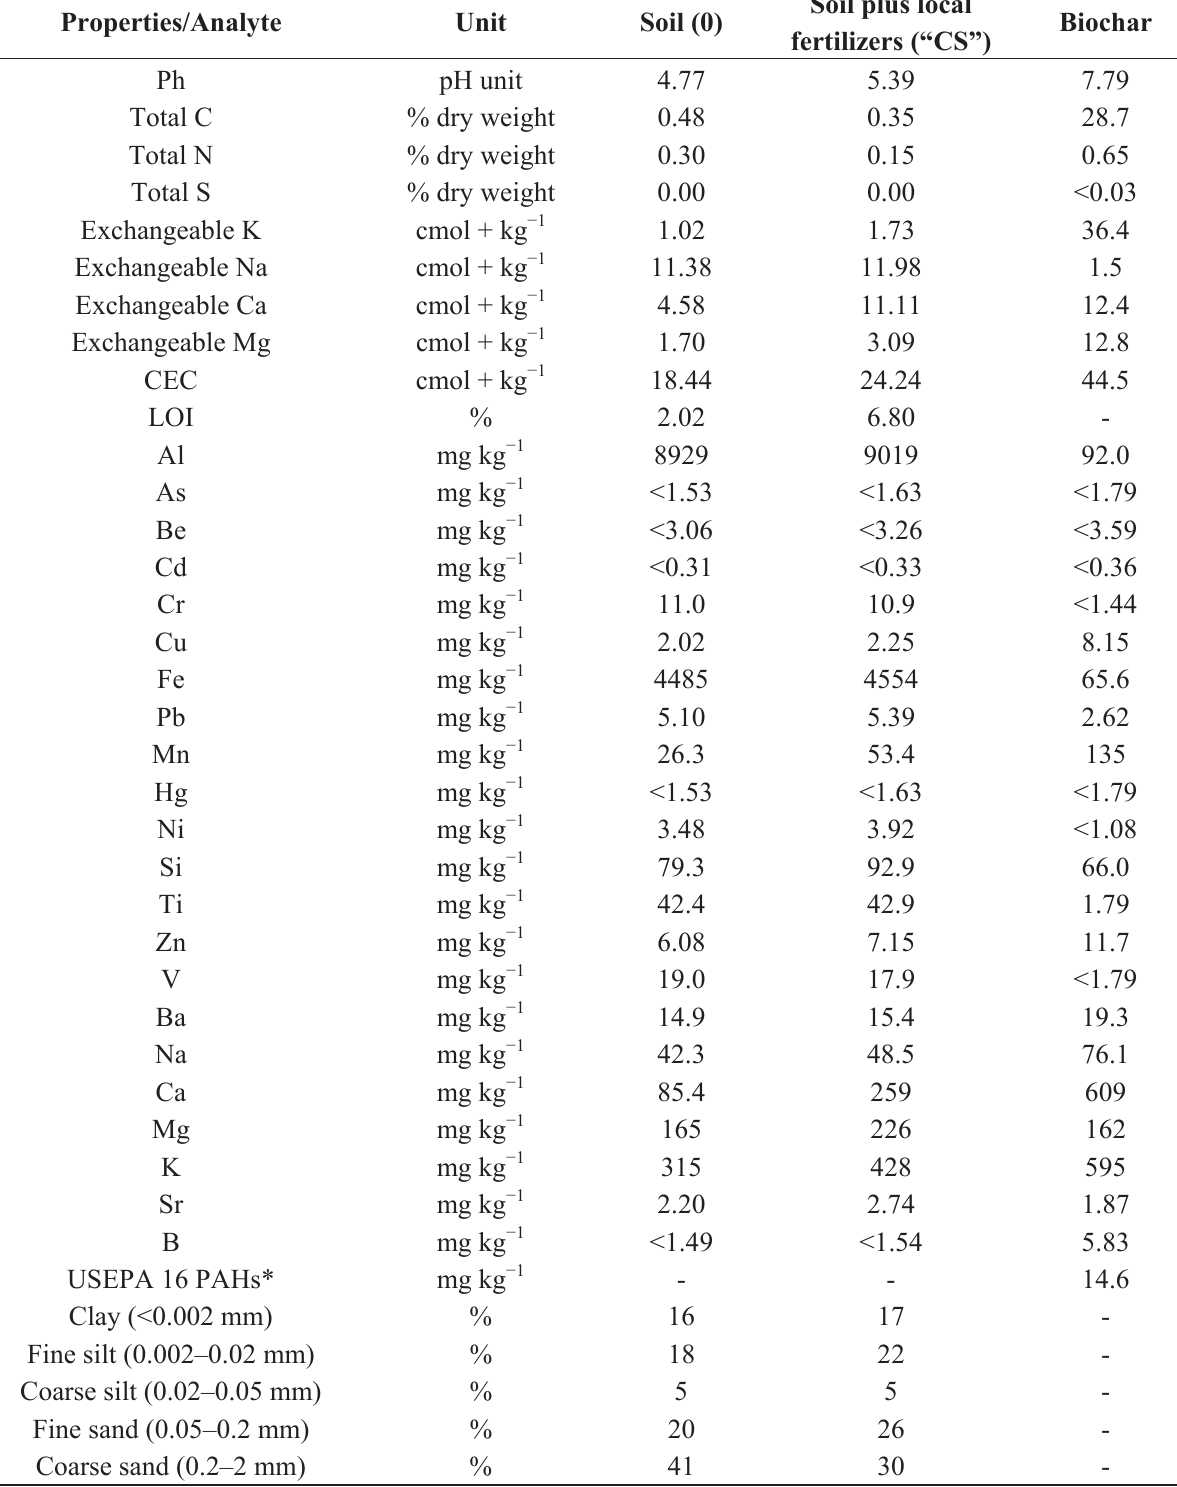
Table 2. Chemical and physical properties of biochar and soil used in the experiment.